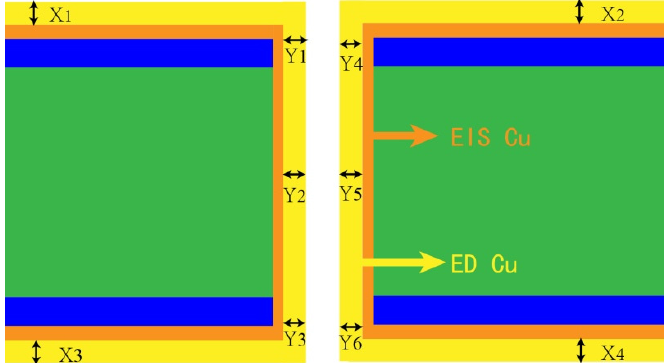
Figure 3. Definition of the throwing power (TP) in a plating through hole (PTH) structure.